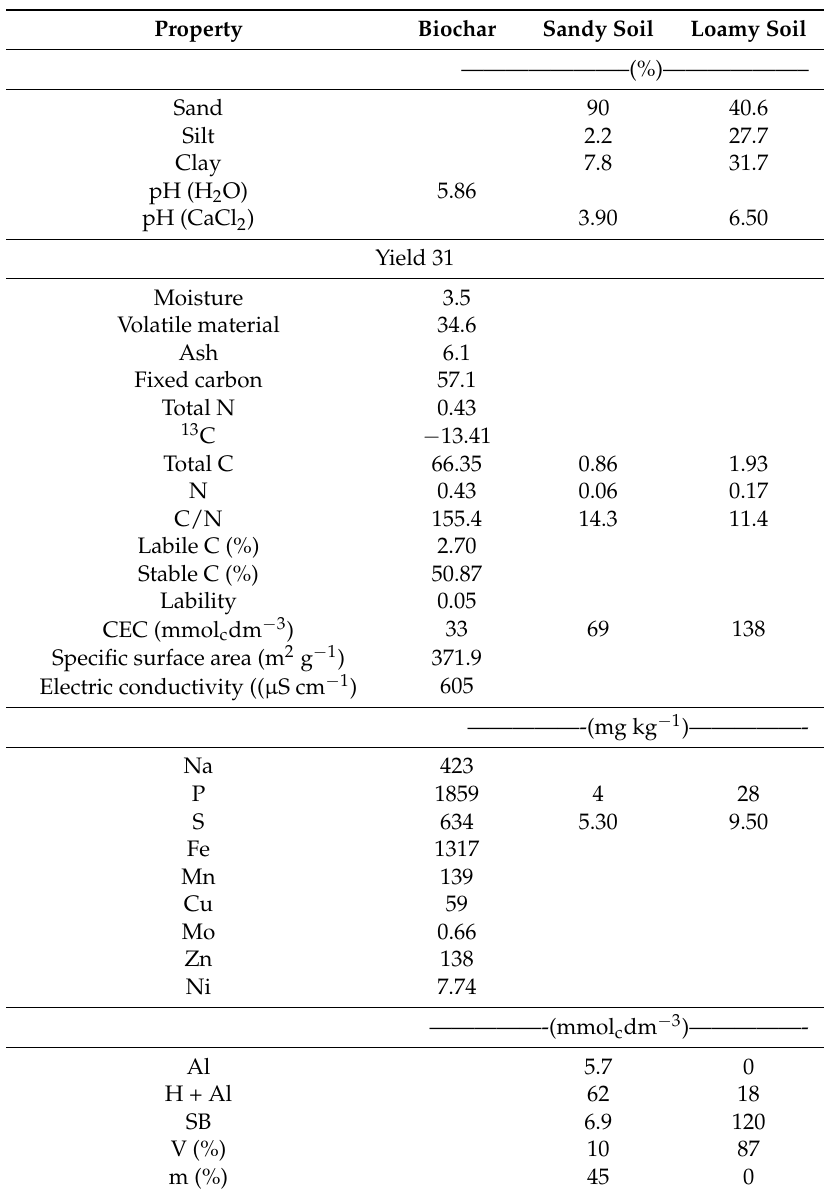
Table 1. Physical and chemical characteristics of biochar Miscanthus , sandy and loamy soil